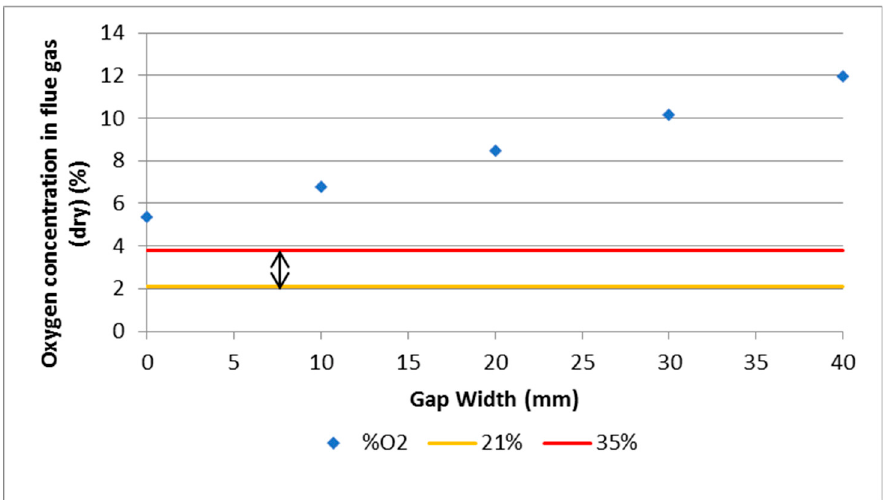
Figure 6. Oxygen concentration in dry flue gas in % vol. measured by flue gas analyzer at varying gap width values. Orange and red lines indicate the range of values corresponding to an optimal combustion air excess of m = 1.1 at 21 to 35% oxygen content in combustion air.